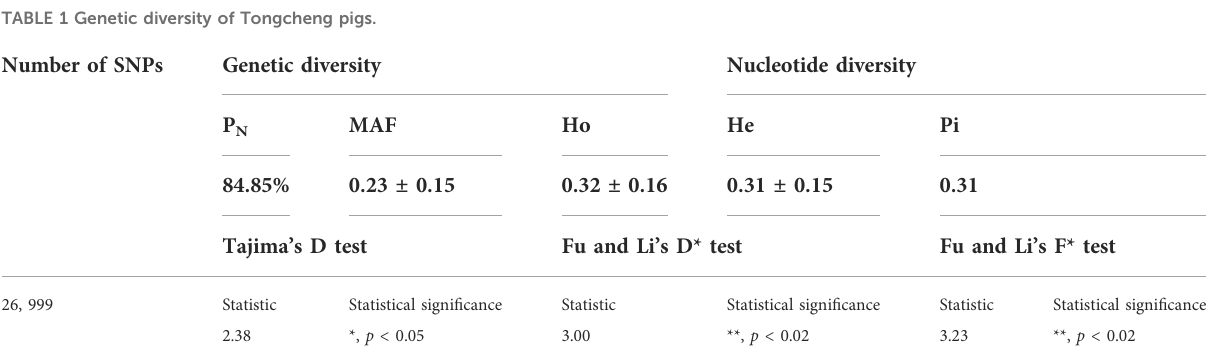
TABLE 1 Genetic diversity of Tongcheng